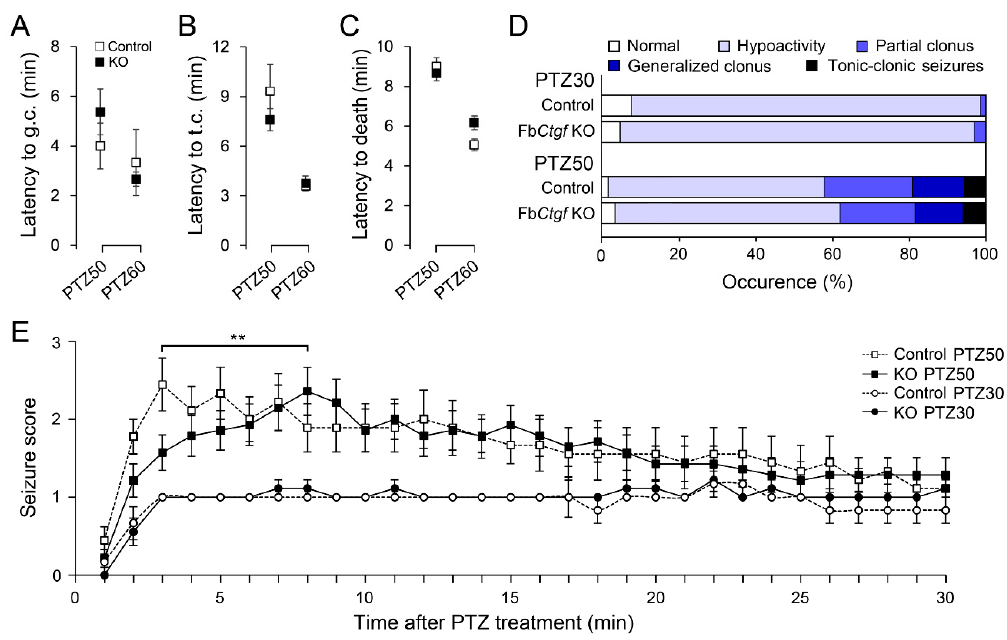
Figure 1. Connective tissue growth factor (Ctgf) protein is expressed in distinct regions of the brain such as the cortical layer VIb, dorsal claustrum and dorsal endopiriform nucleus (DEPN), but not in the ventral claustrum (Cl) or ventral endopiriform nucleus (VEPN) ( A ). The native expression of Ctgf protein was abolished in forebrain-specific Ctgf knockout (Fb Ctgf KO) mice ( B ). Both bars = 200 µ m.